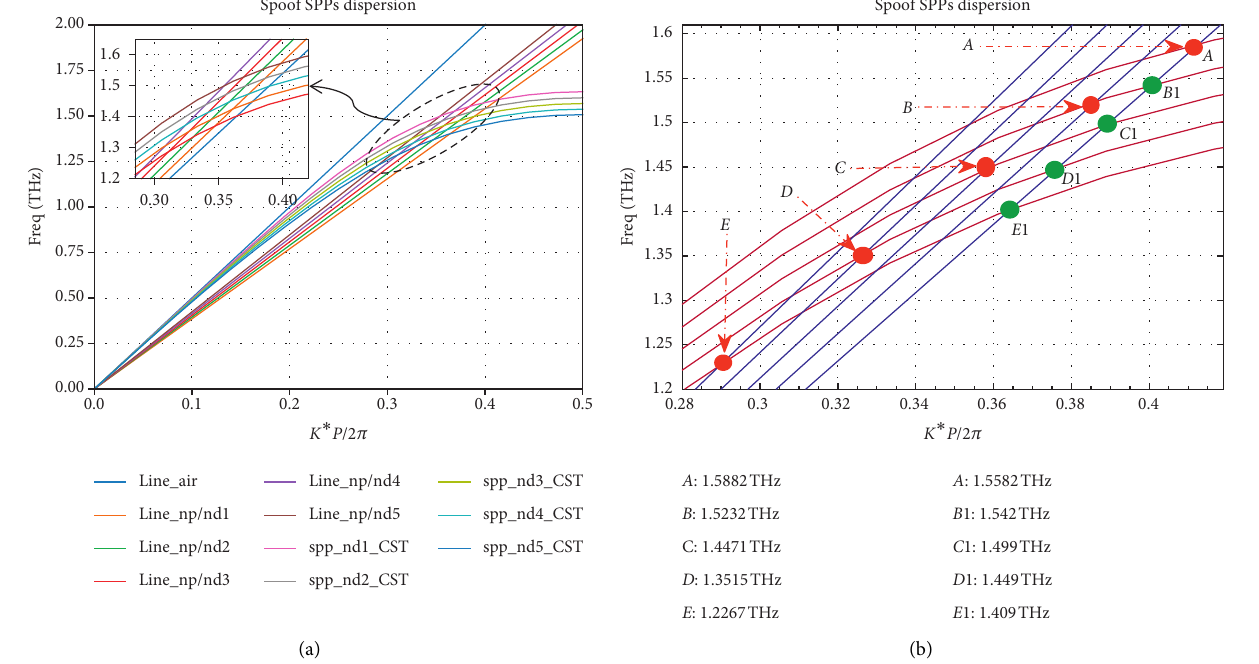
Figure 2: The dispersion curves (a) and the details (b) of the SSPPs supported by periodic metal grooves with p � 60 μ m, a � 20 μ m, and h � 30 μ m. The filling refractive index is nd1 � 1, nd2 � 1.025, nd3 � 1.05, nd4 � 1.075, and nd5 � 1.1, respectively. The refractive index of prism is 1.5.